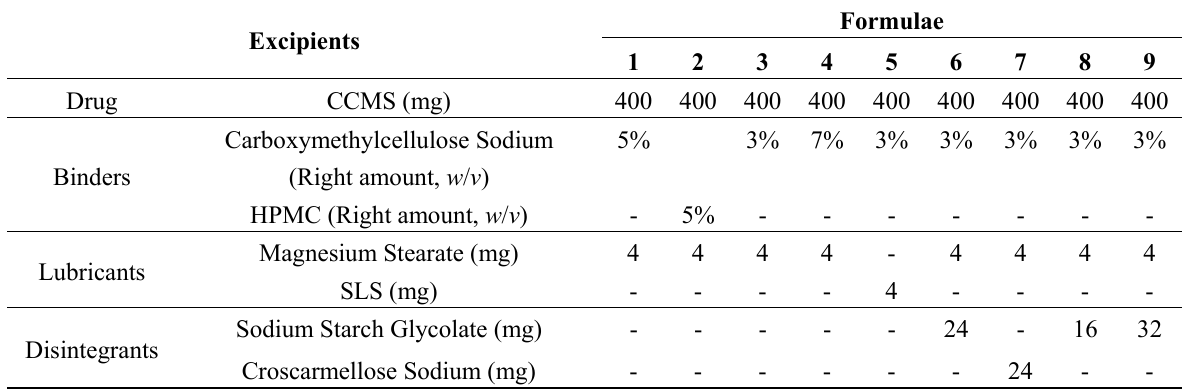
Table 5. Formulae Designation of CCMS Core